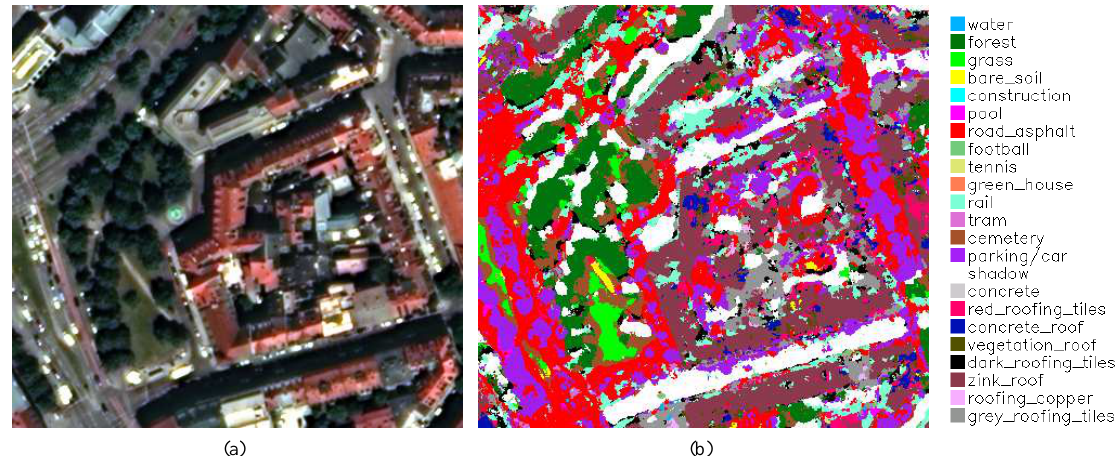
Figure 3: A region of the classification map (INFOFUSE): (a) visible range multispectral image (bands 5,3,2), (b) fusion and classifi- cation by INFOFUSE (this region contains several of the 23 classes) on the step of feature representation using unsupervised cluster- statistics. Separate feature processing and representation on a fi- ing. Representation of input features on a finite domain allows nite discrete domain allows to reduce memory size, storage, and to properly employ multisensory data with different nature and processor requirements. Employing WV-2 multispectral,